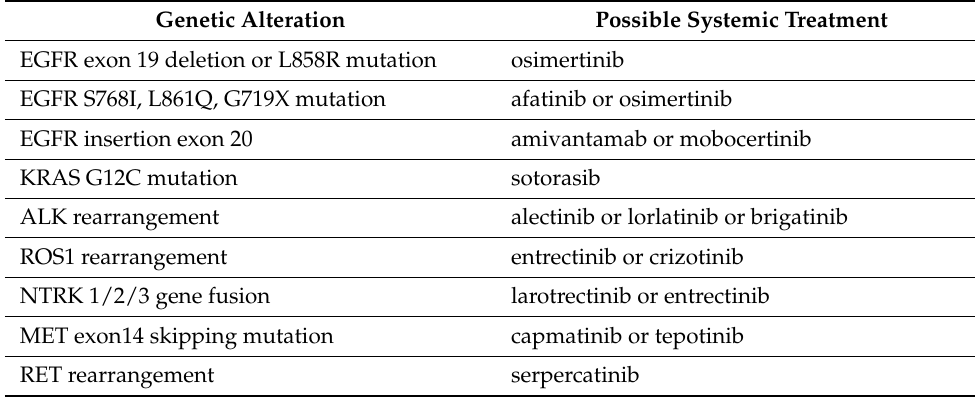
Table 1. Systemic treatment options depending on genetic